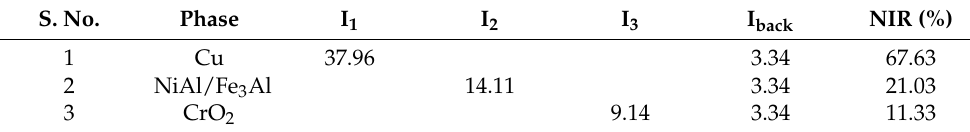
Table 1. Relative phase intensities of the FSPed composite.